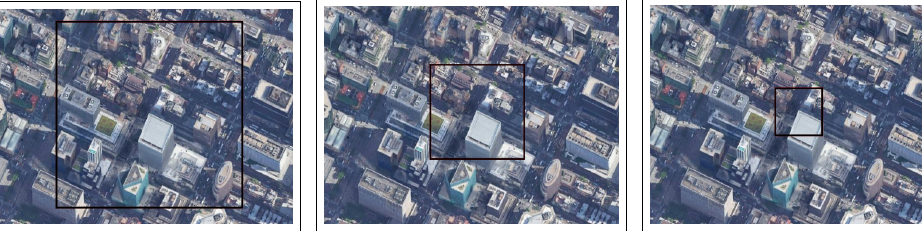
Figure 5. Location #2: 200 m (in the left image), 100 m (in the center image), 50 m (in the right image).